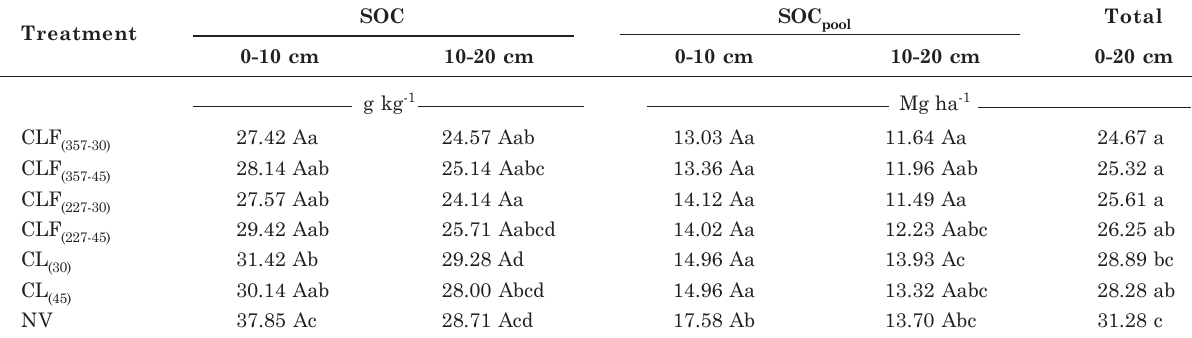
Table 4. Soil organic carbon (SOC) and soil organic carbon pool (SOC pool ) at the soil depths and treatments